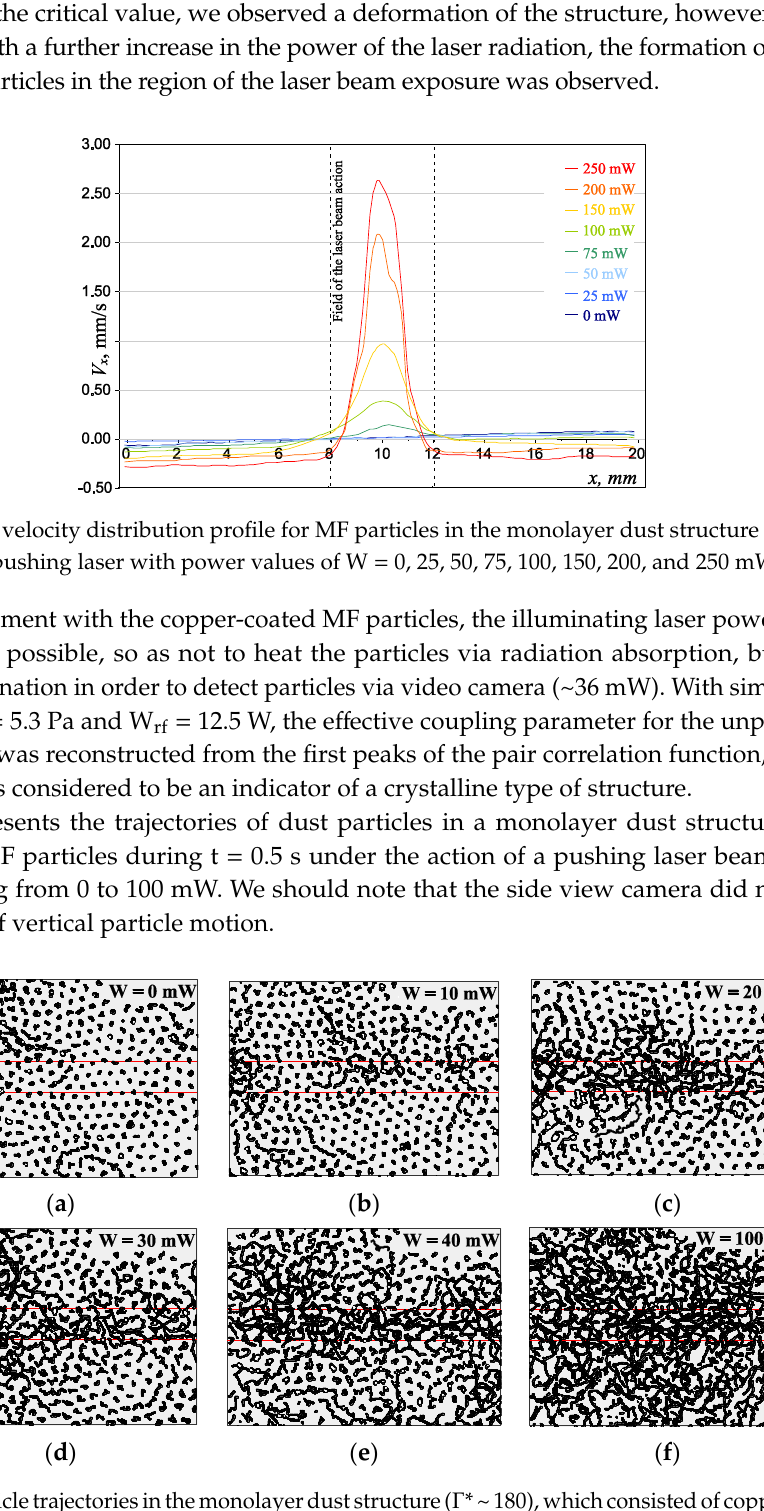
Figure4. Particletrajectoriesinthemonolayerduststructure( Γ *~180), whichconsistedofcopper-coated MF particles in argon at a pressure of P = 5.3 Pa and a discharge power of W rf = 12.5 W during t = 0.5 s under the action of a pushing laser beam with a width of ~4 mm and laser power values of W: ( a ) W = 0 mW; ( b ) W = 10 mW; ( c ) W = 20 mW; ( d ) W = 30 mW; ( e ) W = 40 mW; ( f ) W = 100